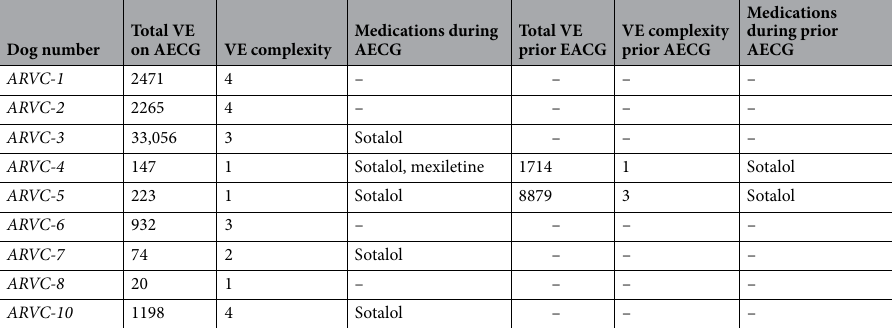
Table 2. Results of AECG recordings in the nine ARVC Boxers that had at least one ECG performed. Results of the recording more recently performed prior to sample collection and a previous AECG at diagnosis of ARVC are displayed, including the total number of ventricular ectopies (VE) and the complexity of ectopy along with relevant anti-arrhythmic medication being administered at the time of recording.